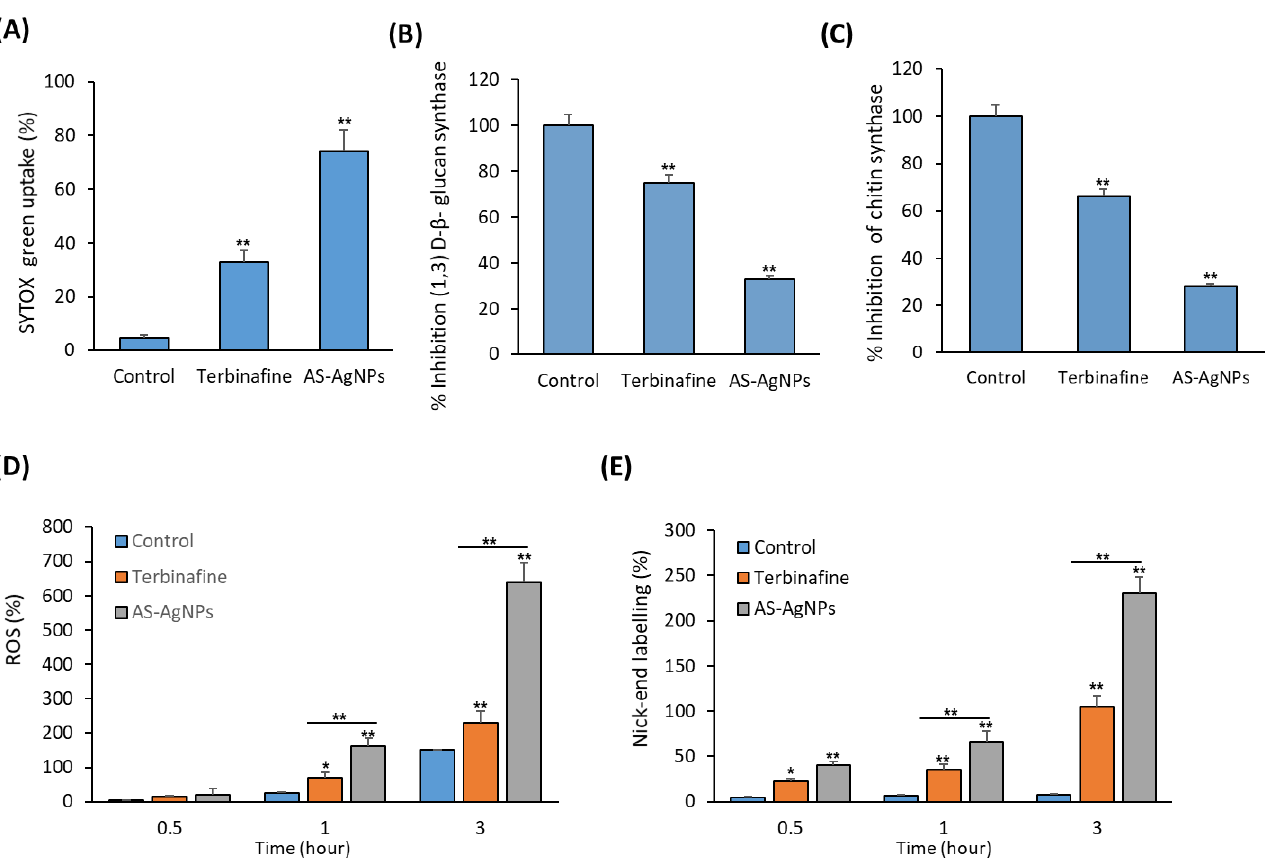
Figure 5. In vitro mechanistic studies of antifungal action of AS-AgNPs against T. rubrum . ( A ) Effect of AS-AgNPs (128 µ g/mL) on SYTOX ® Green uptake into T. rubrum after 24 h of treatment. ( B ) % Inhibition of β -(1,3)- D -glucan synthase in the absence or presence of AS-AgNPs (128 µ g/mL) against. T. rubrum . ( C ) % Inhibition of chitin synthase in the absence or presence of AS-AgNPs (128 µ g/mL) against T. rubrum . ( D ) Effect of AS-AgNPs (128 µ g/mL) on ROS release from T. rubrum after treatments of different durations. ( E ) Effect of AS-AgNPs (128 µ g/mL) on the nick-end labeling of T. rubrum after treatments of different durations. Values are mean ± SD of three independent experiments (* p < 0.05, ** p < 0.05 compared to control non-treated cells).